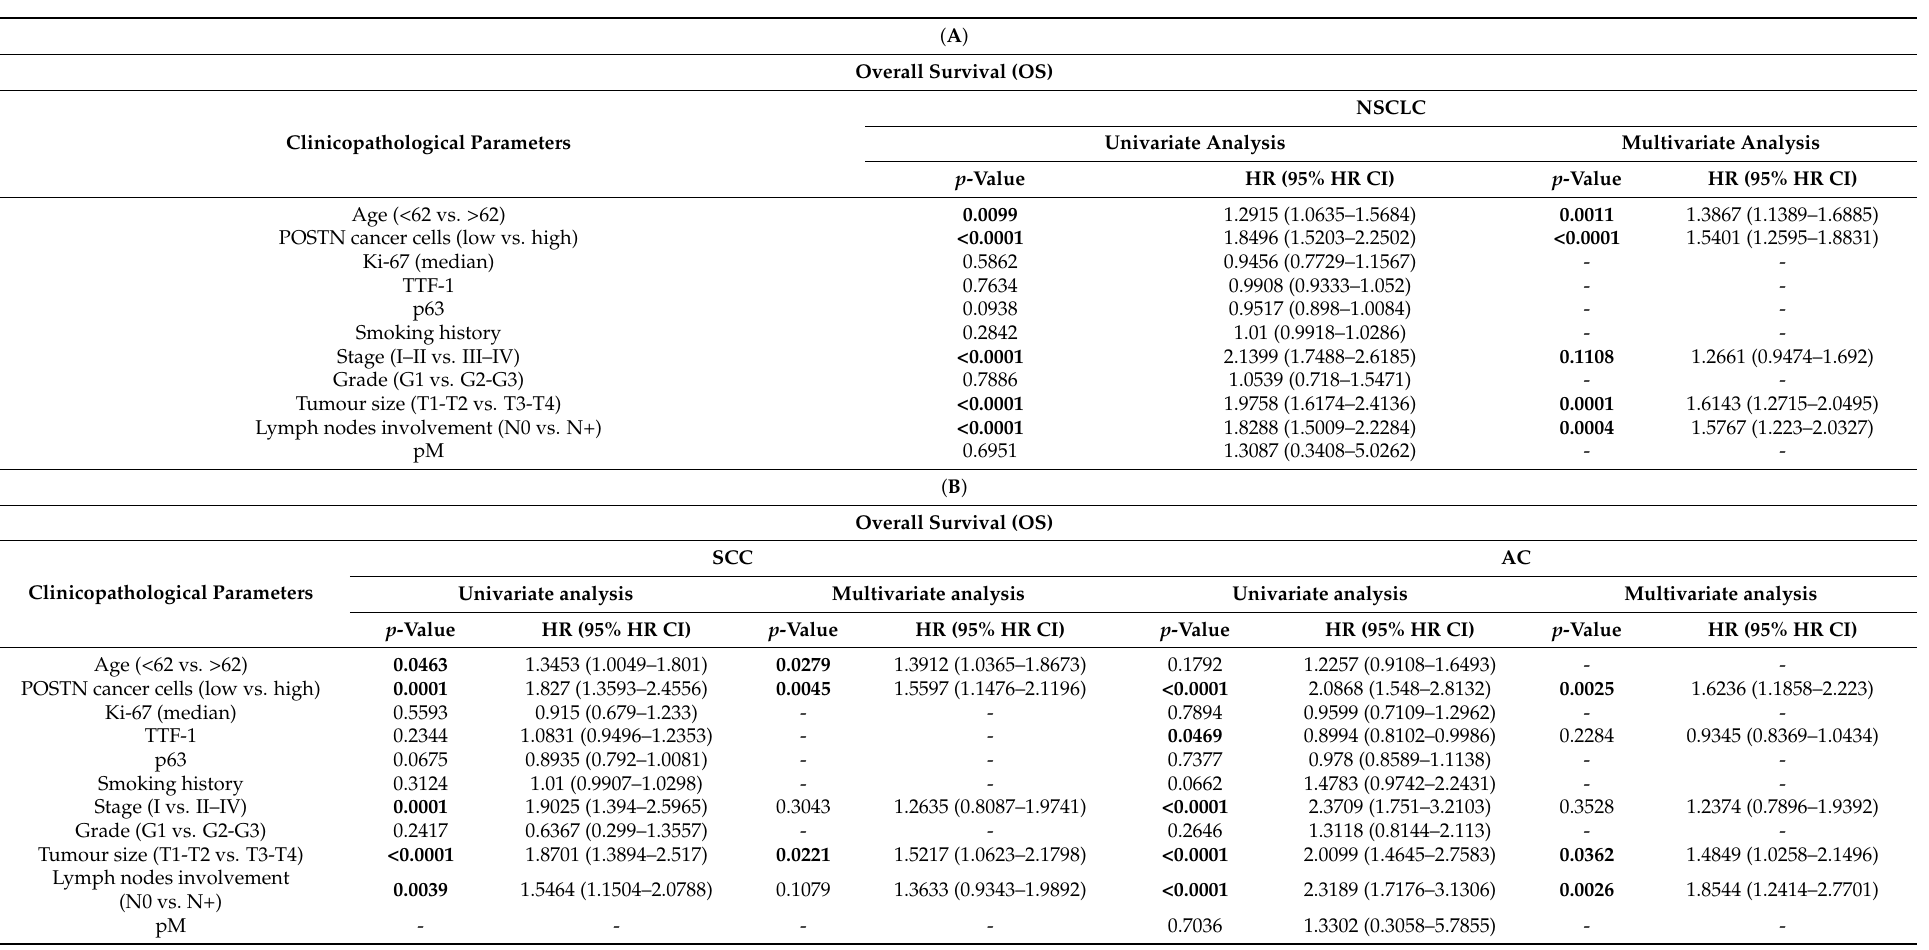
Table 1. Univariate and multivariate Cox analyses of overall survival of patients with ( A ) non-small cell lung cancer (NSCLC) as well as ( B ) squamous cell carcinoma (SCC) and adenocarcinoma (AC) of the lung.